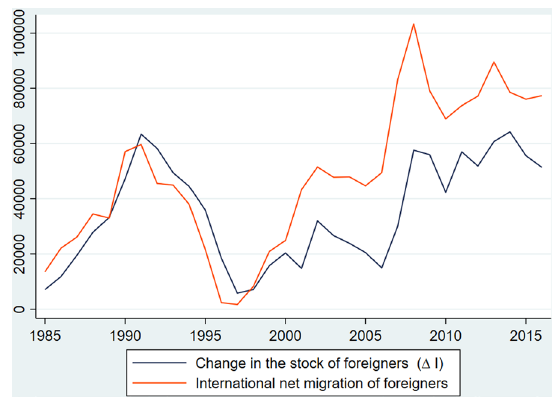
Fig. 7 Change in the stock of foreigners versus international net migration of foreigners in Switzerland, 1985–2016. Notes: Aggregate data for entire Switzerland. Source: Own calculations based on data from Federal Statistical